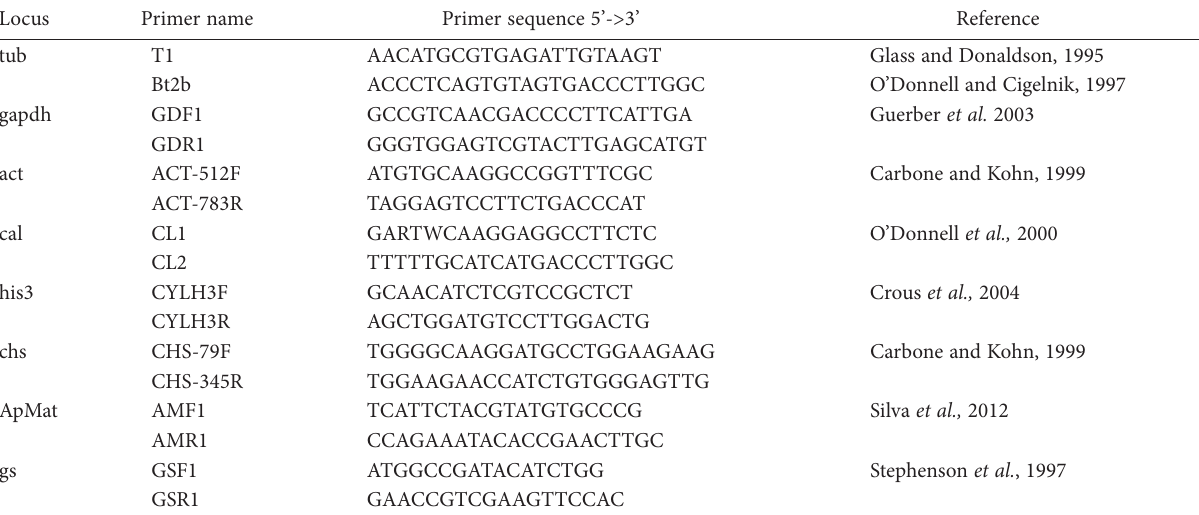
Table 2. Primers used in this study.